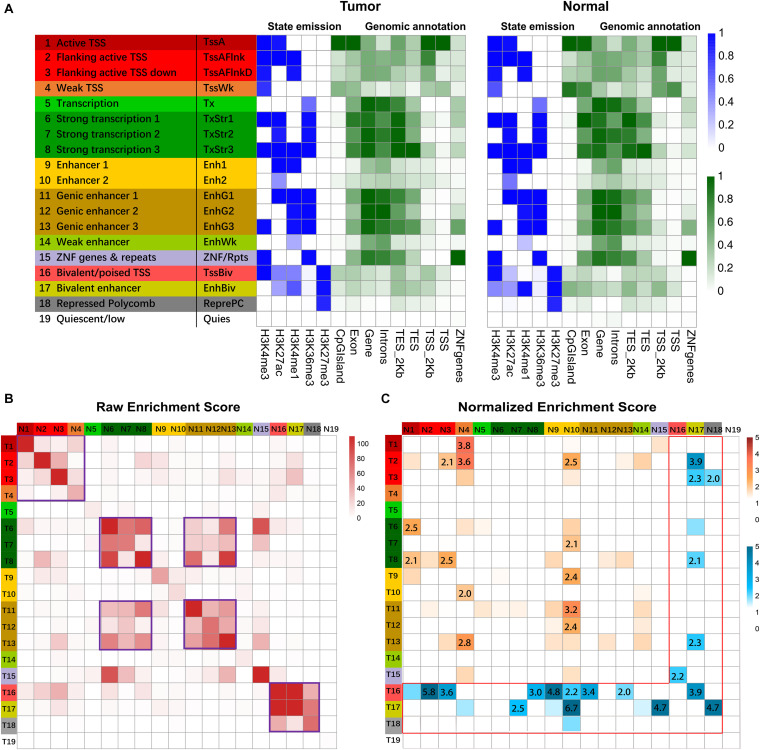
Chromatin state analysis. (A) ChIP signals matrix showed the histone modification profiles of tumor samples and normal samples for the 19 states inferred by the ChromHMM algorithm. First column gave state number and candidate state description, and second column gave the state abbreviations. In the heatmap of the emission parameter, each row corresponded to a different state, and each column corresponded to a different histone mark. The darker blue color corresponded to a higher frequency of occurrence of the mark in the state on the scale from 0 (white) to 1 (blue). The heat map of Genomic annotations displays enrichment for various external genomic annotations. A darker green color corresponded to a higher enrichment on the genomic feature. Overlap of different genomic features (CpG island, Exon, Gene, Intron, TES_2kb, TES, TSS_2kb, TSS, ZNF genes) with chromatin state called in tumor and normal cells. TES indicated transcription end site, and TES_2kb indicated regions within 2kb of the TES. TSS indicated transcription start site, and TSS_2kb indicated regions within 2kb of TSS. (B) Heatmap showed the raw enrichment score of state transitions between normal and tumor samples. The color bars on the left and top corresponded to the color bar of state description in (A). “T” on left color bar indicated tumor sample, and “N” on the top color bar indicated normal samples. The frequent state transitions were highlighted with purple frame. (C) Heatmap showed normalized enrichment score of transitions of chromatin states from normal to GC samples. The color intensities range from white (relative enrichment < 1) to orange and blue (relative enrichment > 1). The normalized enrichment score of more than two were shown. The region with non-repressive states was labeled with orange color, and the region with the repressive state was labeled with a blue color with red frame.